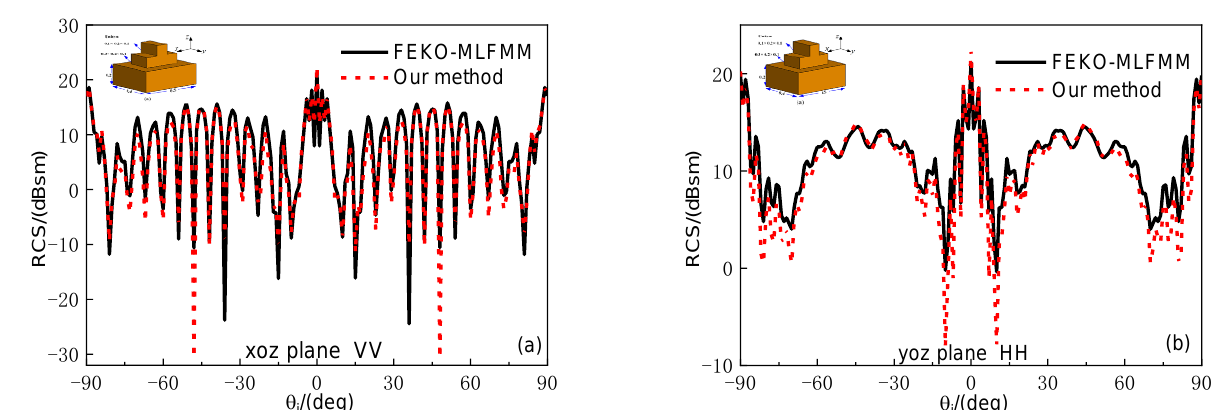
Figure 7. Monostatic scattering of combined cuboid using our method and MLFMM ( a ) xoz plane VV; ( b ) yoz plane HH.